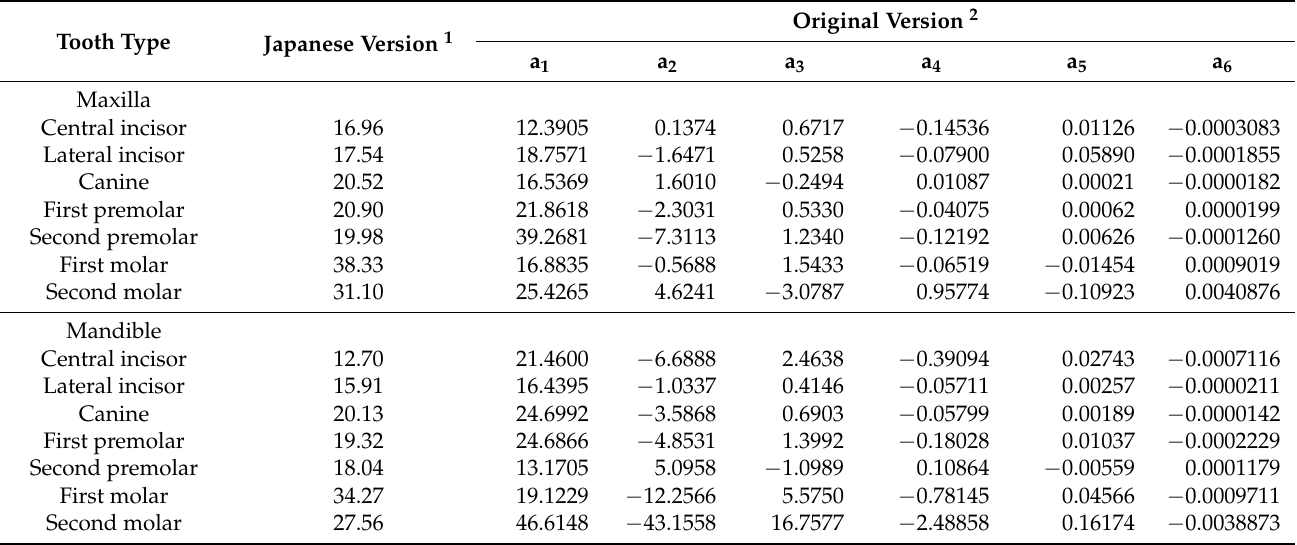
Table 1. Coefficients of the function of periodontal epithelial surface area (PESA) of the original version and the Japanese version for each tooth